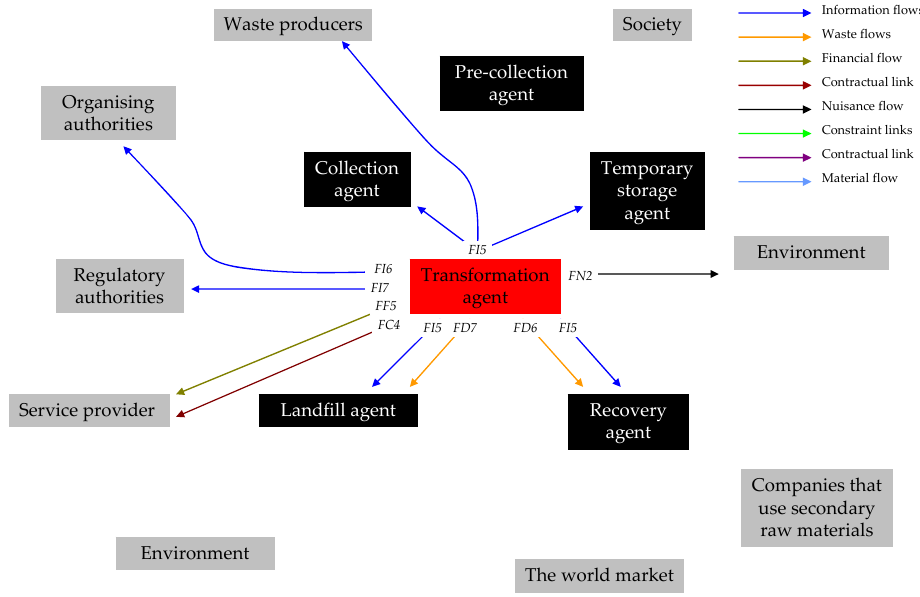
Fig. 5. The functional block diagram of relationships generated by a “transformation Figure 5: The functional block diagram of relationships generated by « transformation agent » 11